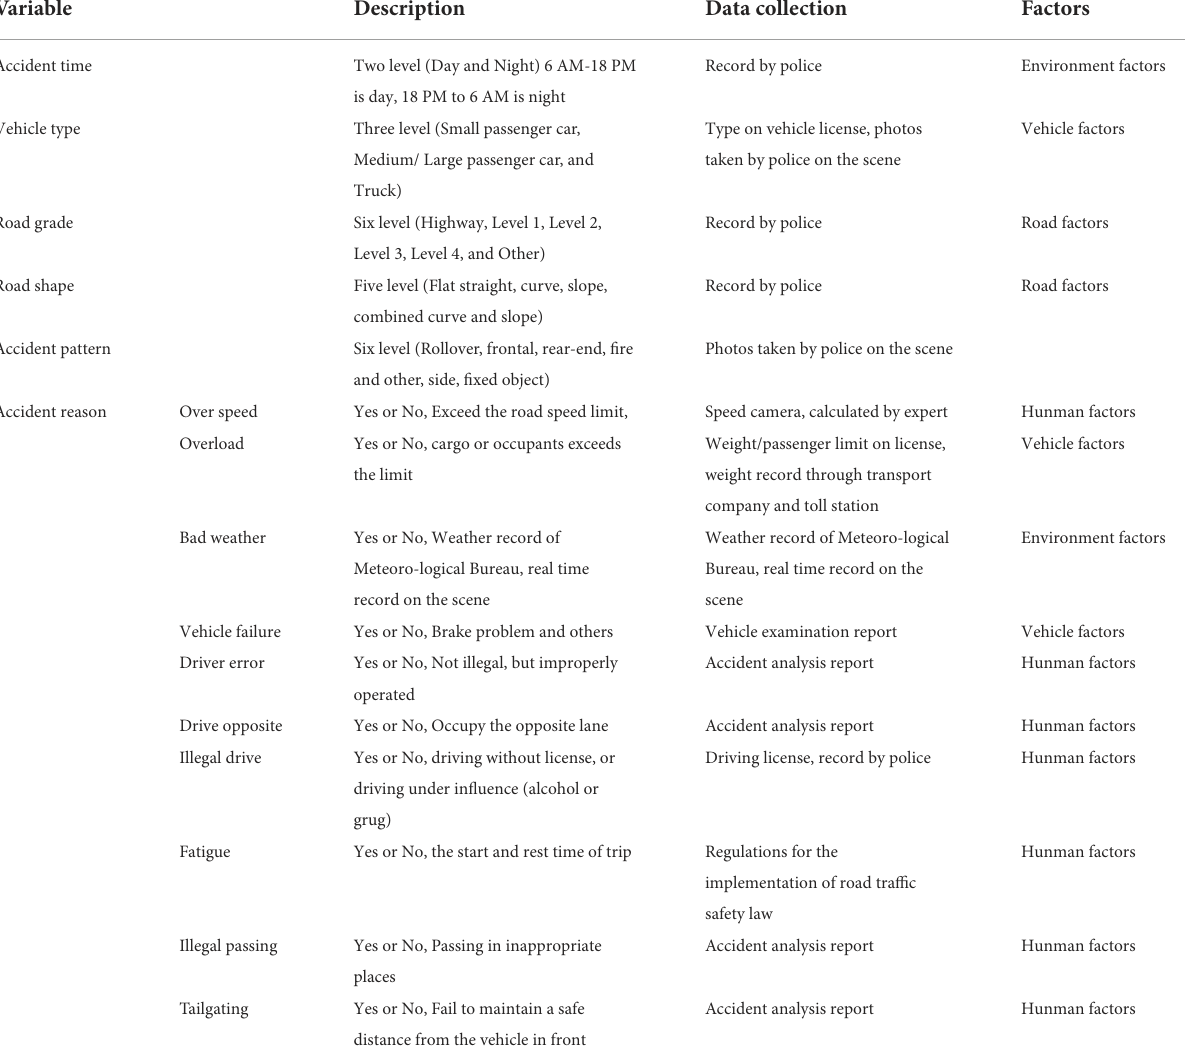
TABLE 1 The classification of factors, data collection, and description of